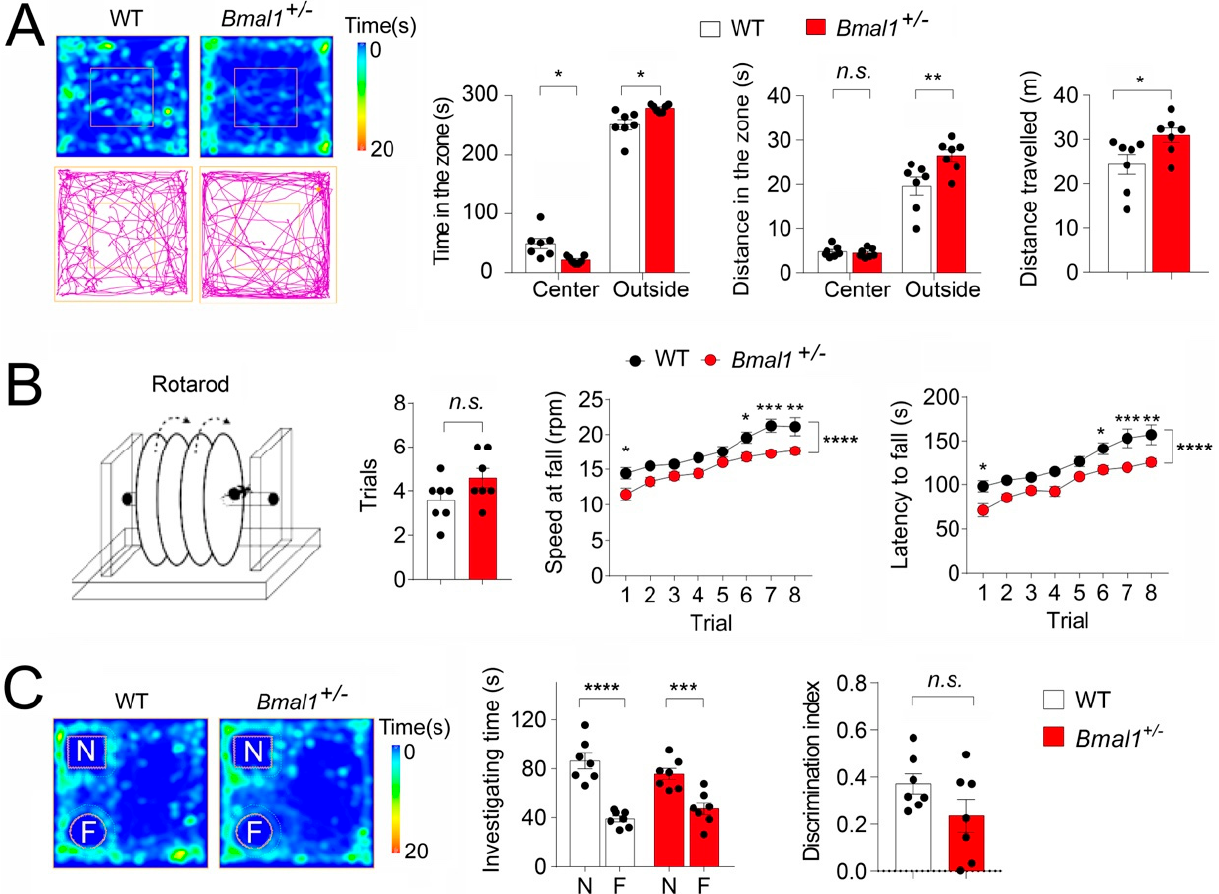
Figure 5. Increased anxiety-like behavior and deficits in motor coordination but intact novel object recognition memory in Bmal1 +/ − mice. ( A ) The open field test. Left: Representative heat maps (top) and track plots (bottom) from a WT and a Bmal1 +/ − mouse. The heat map indicates time spent at the location, and the track plot indicates the distance traveled during the test. Right: Bar graphs indicate time in the center and outside zones, distances traveled in the center and outside zones, and the total distances traveled. Note that the Bmal1 +/ − mice spent less time in the center zone and more time in the outer zone as compared to the WT mice. (F (1,24) genotype = 2.566 × 10 − 29 , p > 0.999, two- way ANOVA and center, t = 3.081; p = 0.0102; outside, t = 3.081; p = 0.0102, Bonferroni’s post hoc comparison). The Bmal1 +/ − mice also traveled a longer distance in the outer zone but a similar dis- tance in the center as compared to WT (F (1,24) genotype = 6.938, p = 0.0145, two-way ANOVA and center t = 0.1799; p > 0.9999; outside, t = 3.905; p = 0.0013, Bonferroni’s post hoc comparison). Bmal1 +/ − also showed a significant increase in the total distance traveled as compared to WT mice (t (12) = 2.362, p = 0.0359, Student’s t -test). n = 7 mice/group. ( B ) The rotarod test. Mice were pretrained to stay on the rotating rod (4 rpm) for at least 1 min before entering the trails. Left: A diagram of the rotarod testing equipment. Middle: A bar graph indicates that the number of pretrials was not different between the WT and Bmal1 +/ − mice (t (12) = 1.769, p= 0.1024, Student’s t -test). Right: Line graphs indicate the speed at falling and latency to fall. Note that the performances were improved over the eight trials in both the WT and the Bmal1 +/ − mice (F (7,96) trial = 24.63, p < 0.0001, two-way ANOVA). However, Bmal1 +/ − mice fell at lower speeds as compared to the WT mice (F (1,96) trial = 58.36, p < 0.0001, two- way ANOVA; trial1: t = 3.068, p = 0.0224; trial 6: t = 2.934, p = 0.0334; trial 7: t = 4.135, p = 0.0006; trial 8: t = 3.601, p = 0.0040, Bonferroni’s post hoc comparisons) and showed significantly lower latencies to fall (F (1,96) trial = 66.45, p < 0.0001, two-way ANOVA and trial1: t = 3.279, p = 0.0116; trial 6: t = 2.933, p = 0.0335; trial 7: t = 4.107, p = 0.0007; trial 8: t = 3.882, p = 0.0015, Bonferroni’s post hoc com- parisons) as compared to the WT. n = 7 mice/group. ( C ) The novel object recognition test. Left: Rep- resentative heat maps indicate the time spent at the location from a WT and a Bmal1 +/ − mouse. Right: